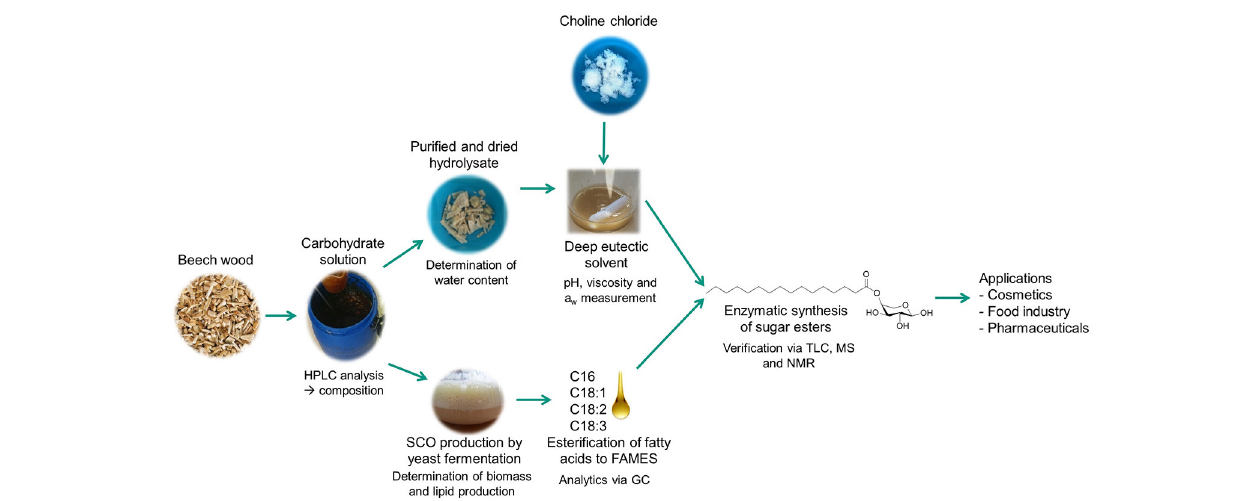
FIGURE 1 | Flowchart of the study. Carbohydrates from beech wood cellulose fiber hydrolysates were used to produce fatty acids in a yeast bioprocess, to form the solvent system and as substrate for the enzymatic reaction to produce fatty acid sugar esters (a.k.a glycolipids). Analytical methods are indicated at each work